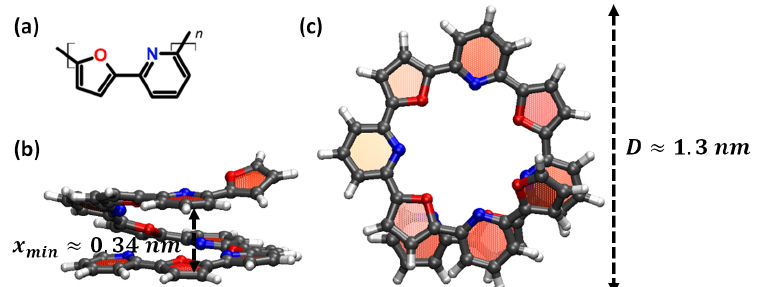
Figure 1. Pyridine-furan (PF) spring with five monomer units (oligo-PF-5 spring): ( a ) Chemical structure of a pyridine-furan monomer unit with heterocyclic rings in cis-configuration. ( b ) Front and ( c ) top views of an oligo-PF-5 spring in the atomistic representation. The spring has one complete turn consisting of approximately 3.5 monomer